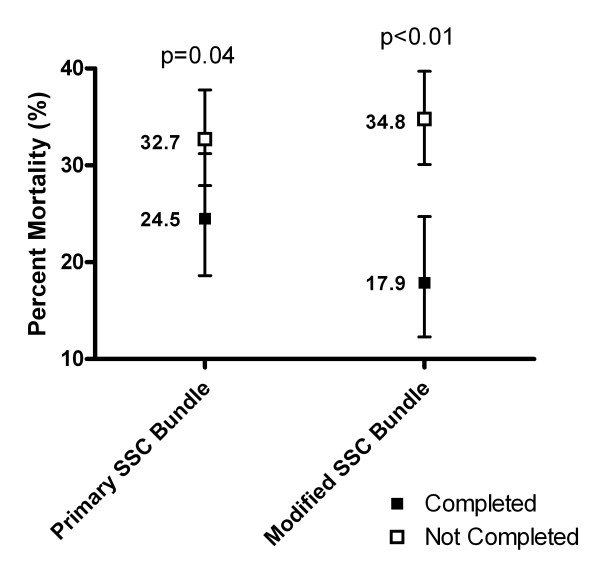
Mortality differences for the Surviving Sepsis Campaign bundles. Mortality differences for the Primary Surviving Sepsis Campaign (SSC) Bundle and the Modified SSC Bundle (includes lactate clearance). Patients with the Primary SSC Bundle completed compared with not completed had mortality of 24.5% (95% confidence interval = 18.6 to 31.2) versus 32.7% (95% confidence interval = 27.9 to 37.8). Patients with the Modified SSC Bundle completed compared with not completed had mortality of 17.9% (95% confidence interval = 12.3 to 24.7) versus 34.8% (95% confidence interval = 30.1 to 39.7). The ratio of the relative risk of death reduction for the Modified SSC Bundle compared with the Primary SSC Bundle was 1.94 (95% confidence interval = 1.45 to 39.1).